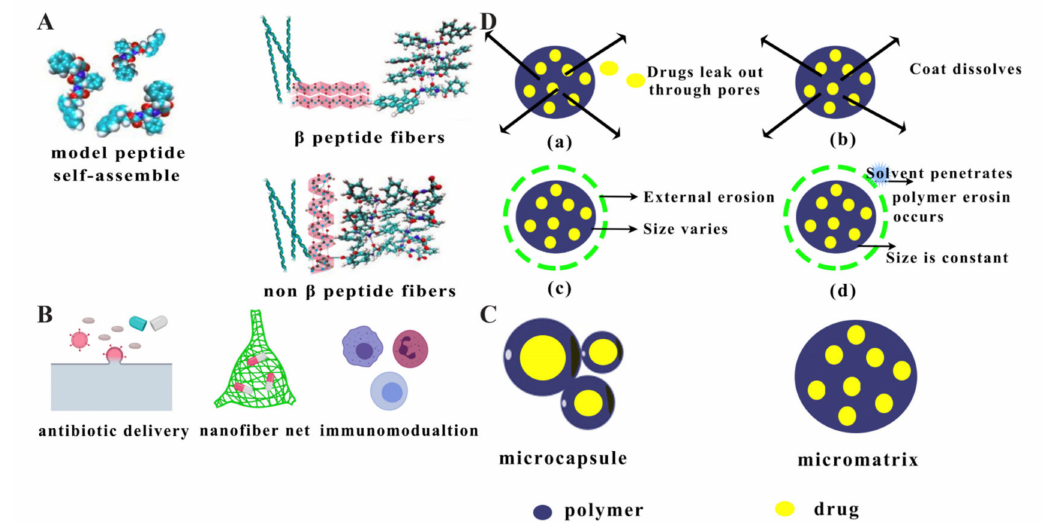
Figure 7. ( A ) Schematic forming model of nanofibres adapted from [136]. ( B ) Different bioactivities of nanofibres. ( C ) Schematic model of microspheres. ( D ) Drug-releasing models of microspheres (( a ) diffusion, ( b ) dissolution, ( c ) surface erosion, ( d ) overall erosion) adapted from